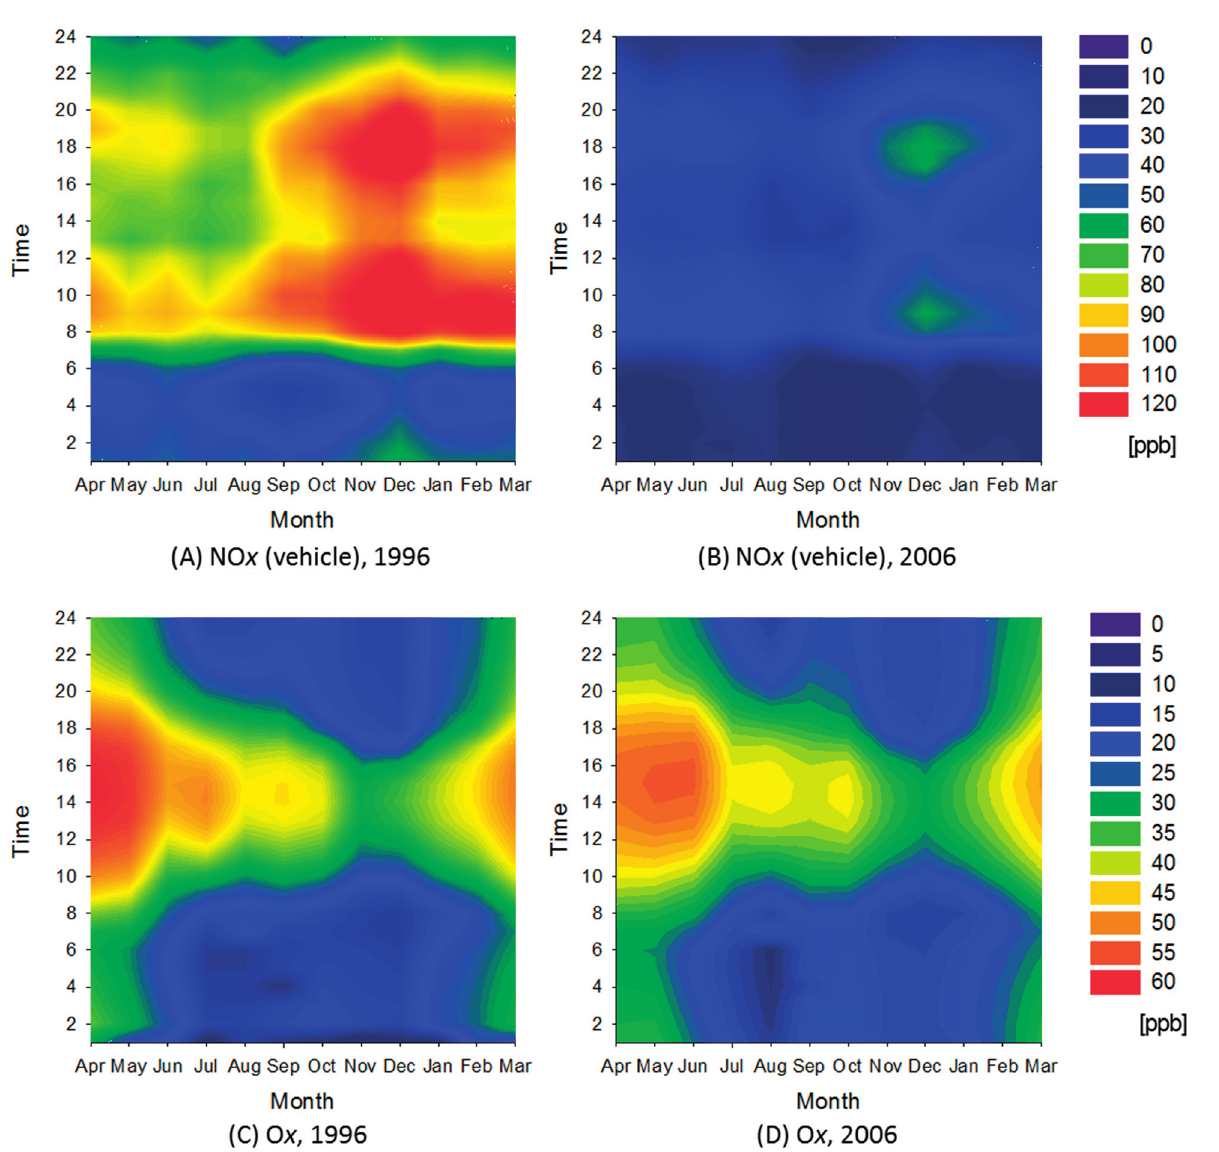
Figure 5. Contour maps for NO x monitoring data from vehicle emission monitoring stations: ( A ) in 1996 and ( B ) in 2006; and for O x ( C ) in 1996 and ( D ) in